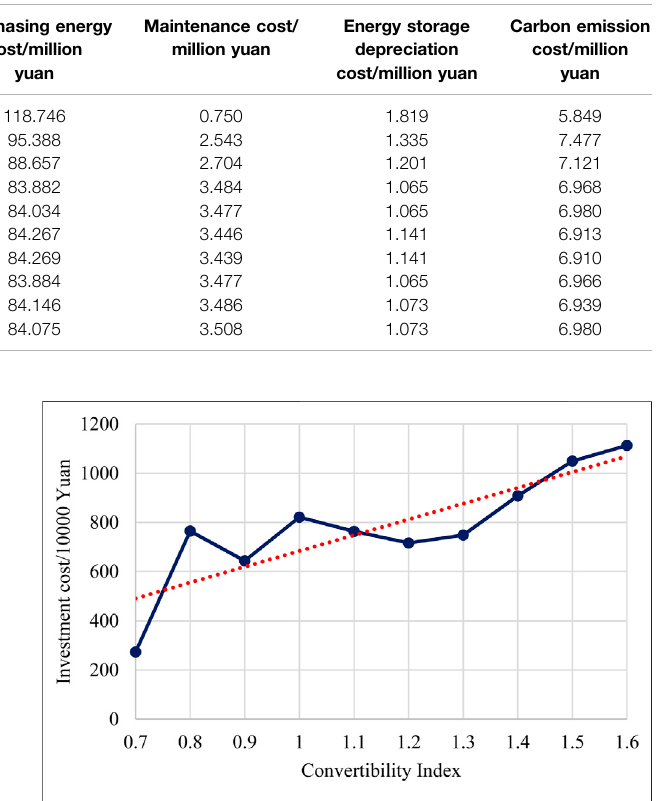
FIGURE 9 | Investment cost with different